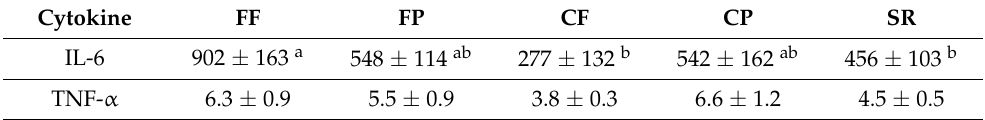
Table 1. Serum IL-6 and TNF- α concentrations (pg/mL) 2 h following LPS injection 1,2 .